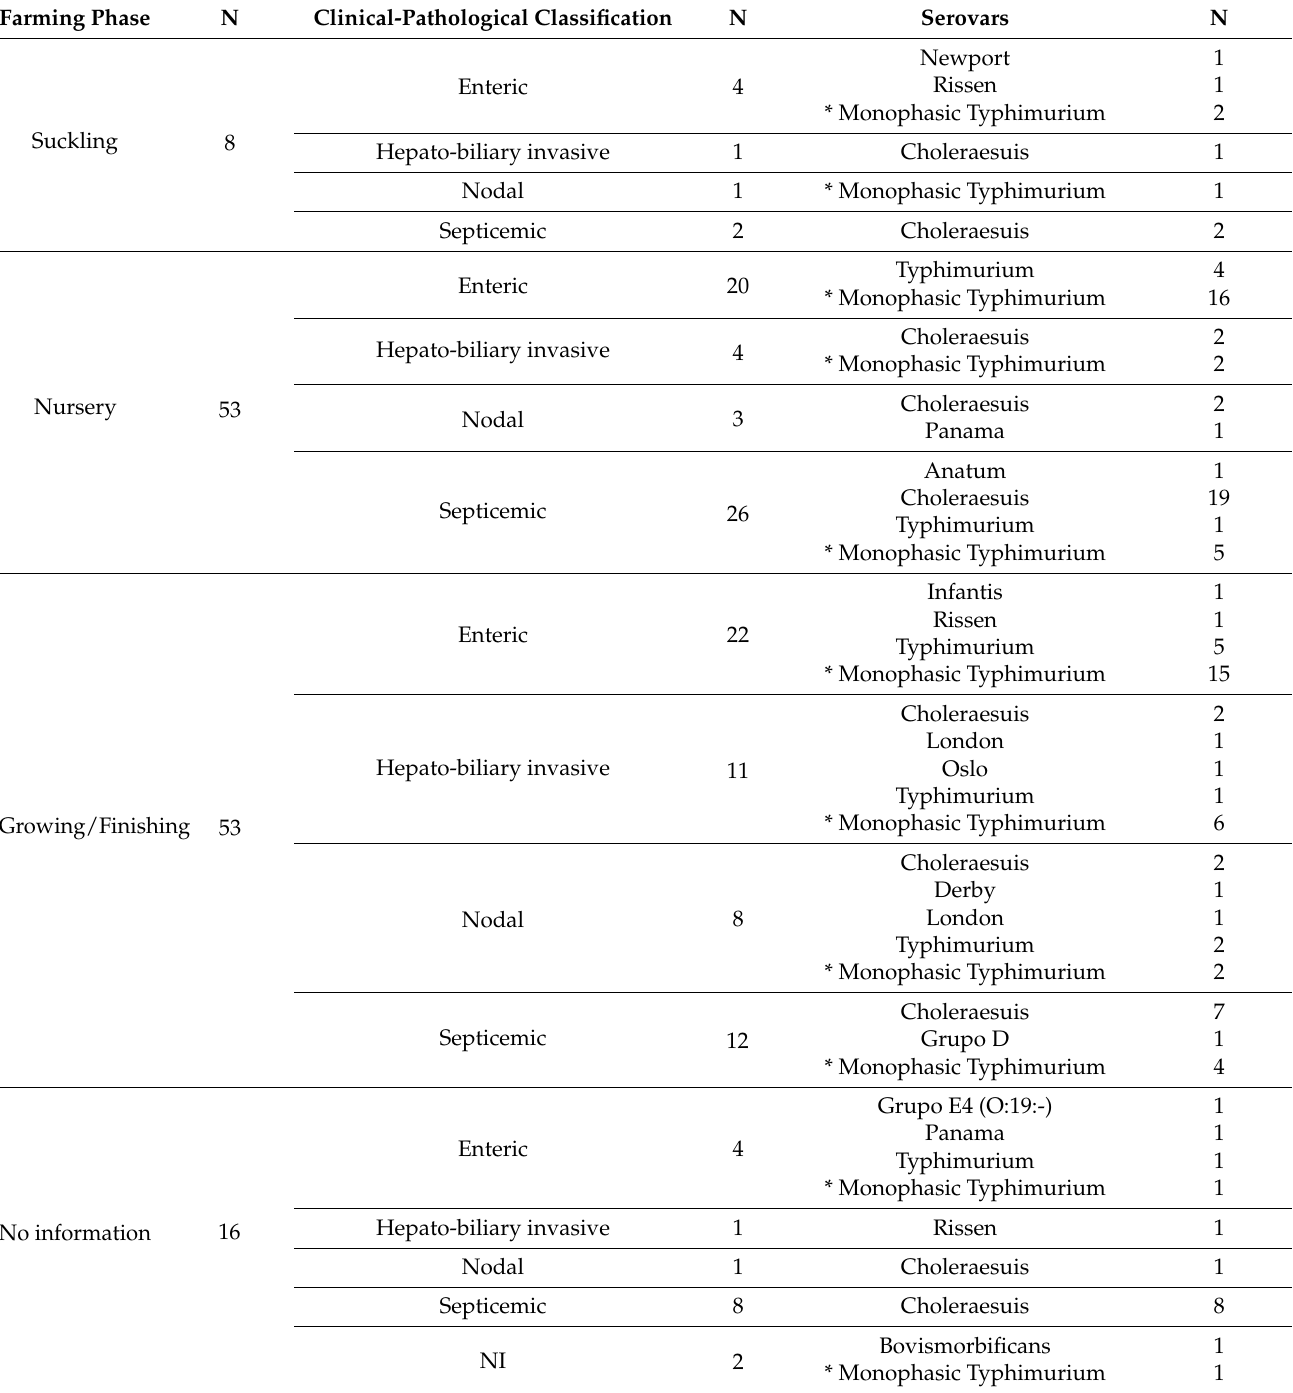
Table 1. Distribution of 130 salmonellosis outbreaks by farming phase, clinical-pathological classification, and serovar. Farming